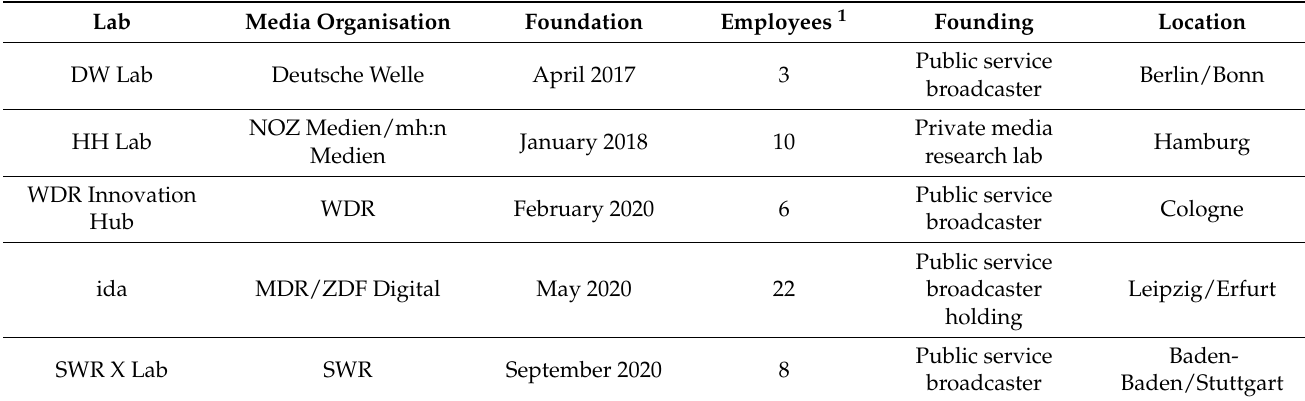
Table 1. Overview of the selected innovation